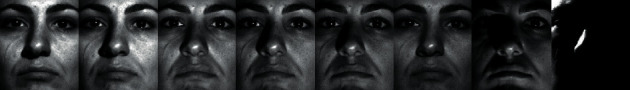
Samples in extended YaleB dataset.